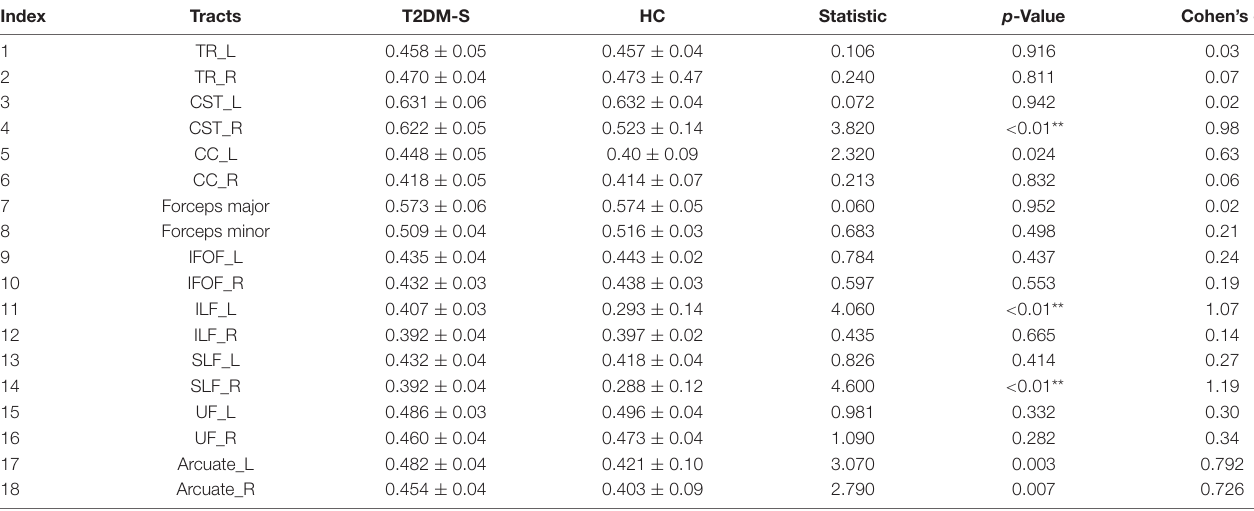
TABLE 2 | Mean FA ( × 100) of 18 fiber tracts for T2DM-S and HC.